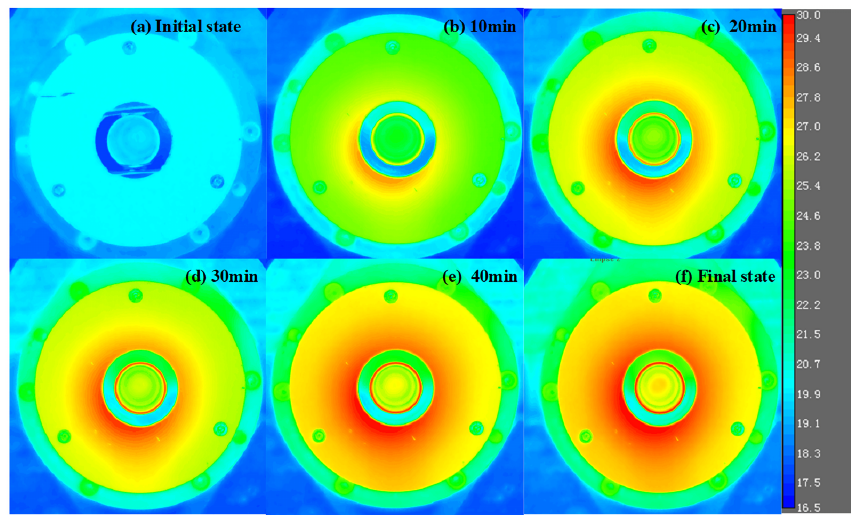
Figure 20. Transient temperature field distribution at different times of the motorized spindle at 2000rpm.